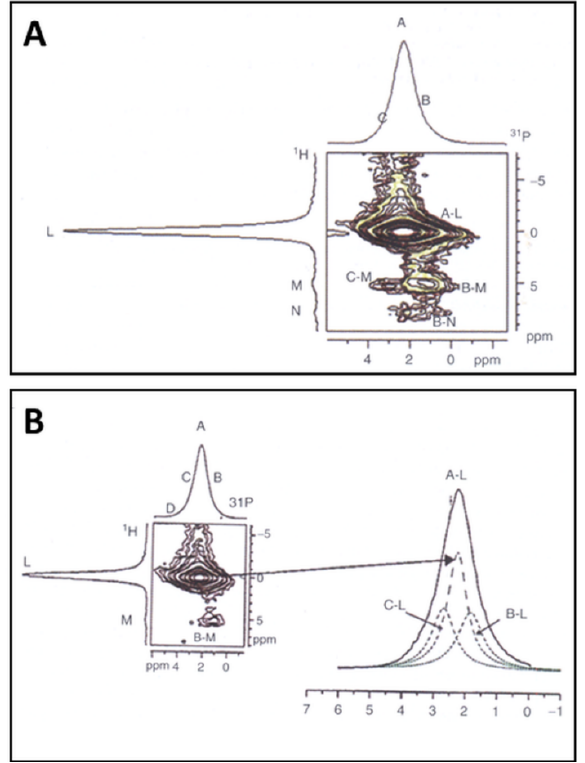
Figure 7. ( A ): 2D- 1 H/ 31 P-CP-HETCOR NMR spectrum of a plasma-sprayed HAp coating [53,54]. Band assignments according to Ref. [21]. ( B ): 2D- 1 H/ 31 P-CP-HETCOR NMR spectrum of a plasma-sprayed HAp coating incubated for 12 weeks in simulated body fluid [55]. The cross-section of the HETCOR spectrum at the proton frequency of band L shows reduction and disappearance, respectively, of the HETCOR signals C-M, B-M, and B-N [54]. © Reprinted with permission from R.B.